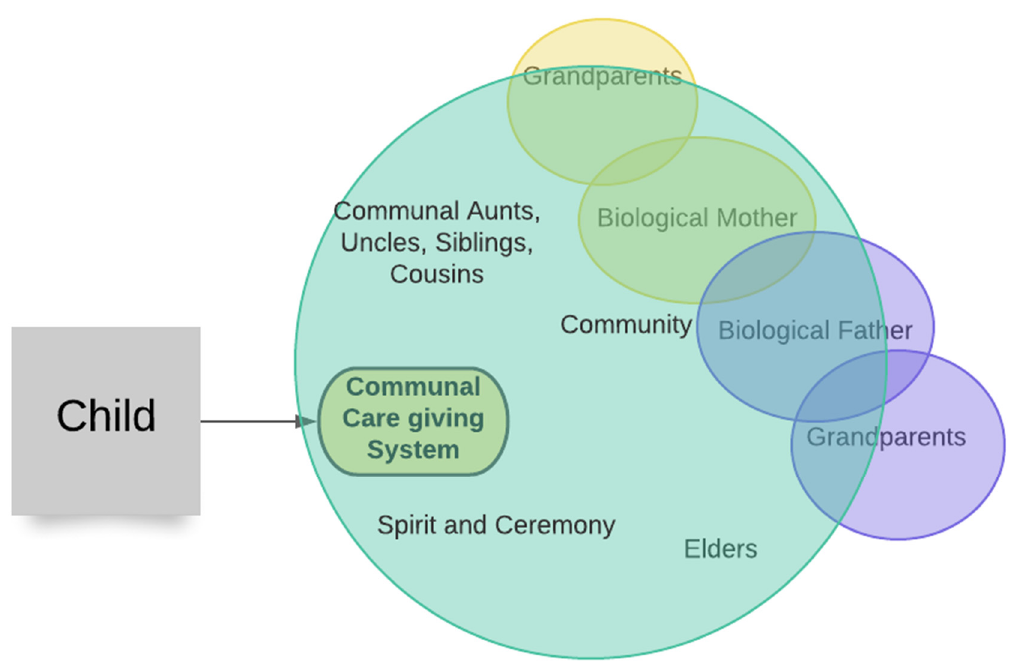
Figure 6. Intersectional view of childcaring within an Indigenous context, which, from early life, creates multiple attachment pathways. Amir and McAuliffe [52] have shown the value of the “in culture” experience as opposed to across-culture experiences. They note ”A general feature of these models is that they all seek in some way to contextualize child development as a dialogue between the individual and the various social, ecological, and cultural inputs they experience” (p. 433). The child is not separate from the cultural context, but an integrated part of it.